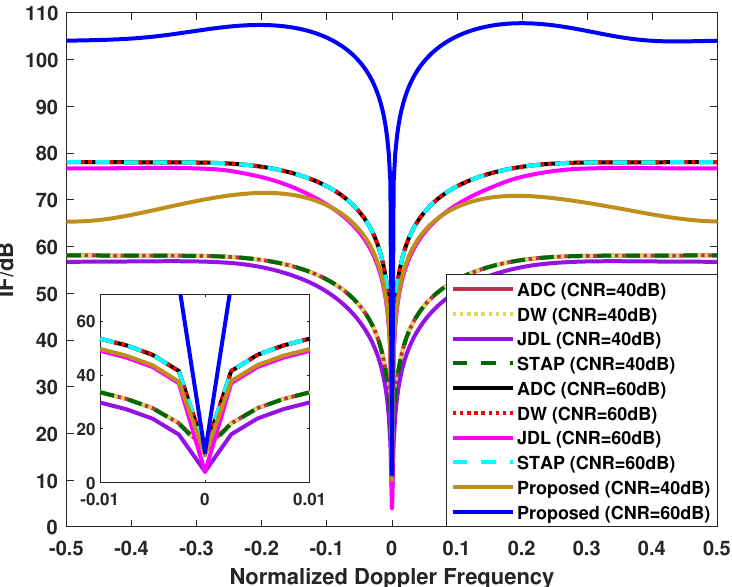
Figure 6. IF versus normalized Doppler frequency for side-looking radar. Figure 7a,b show the IFs of different methods versus normalized Doppler frequency, where for a forward-looking radar with − 90 ◦ and v a = 150 m/s, CNR is fixed at CNR = 50